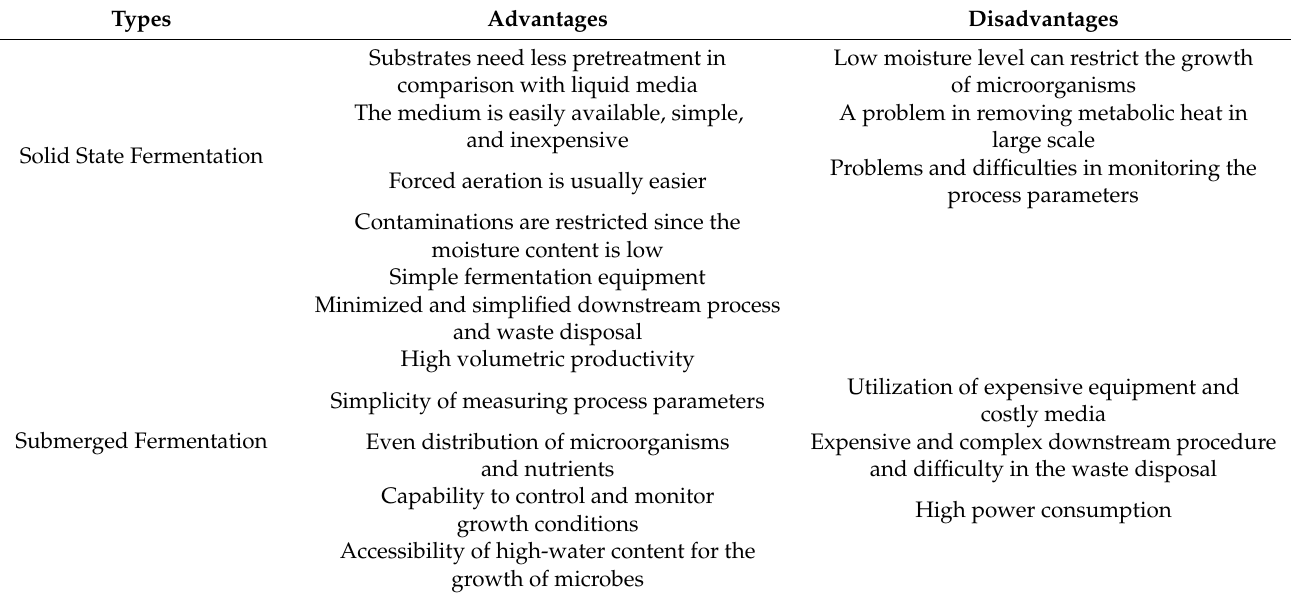
Table 2. Comparison of Solid State Fermentation and Submerged